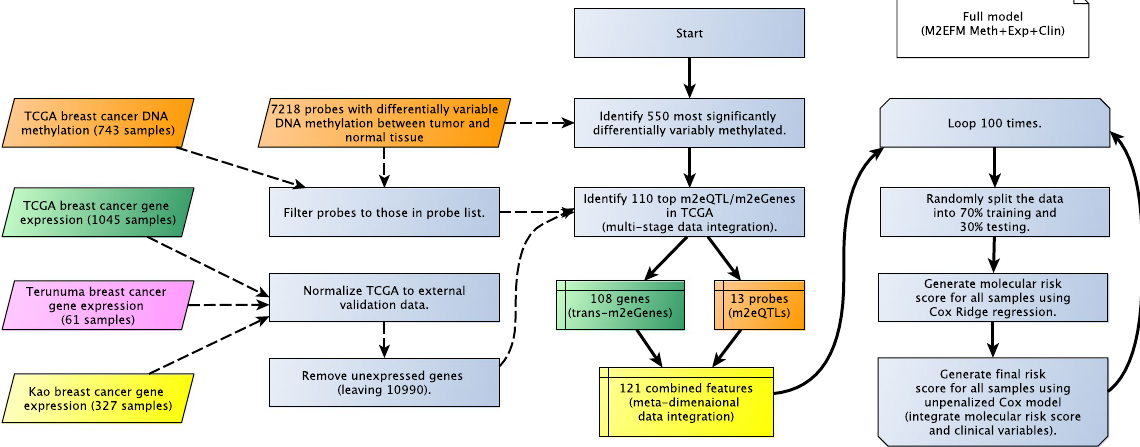
Figure 1. Overview of the M2EFM OS model